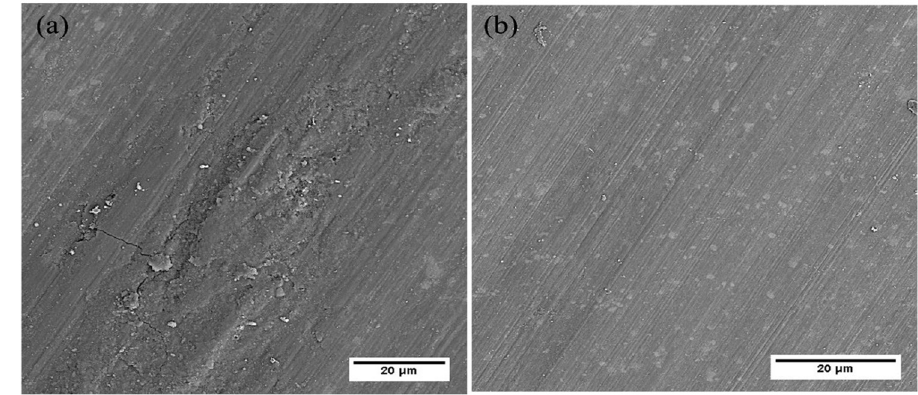
Figure 10: Wear surface of the ( a ) monolithic and ( b ) Al/10 Vol% alumina